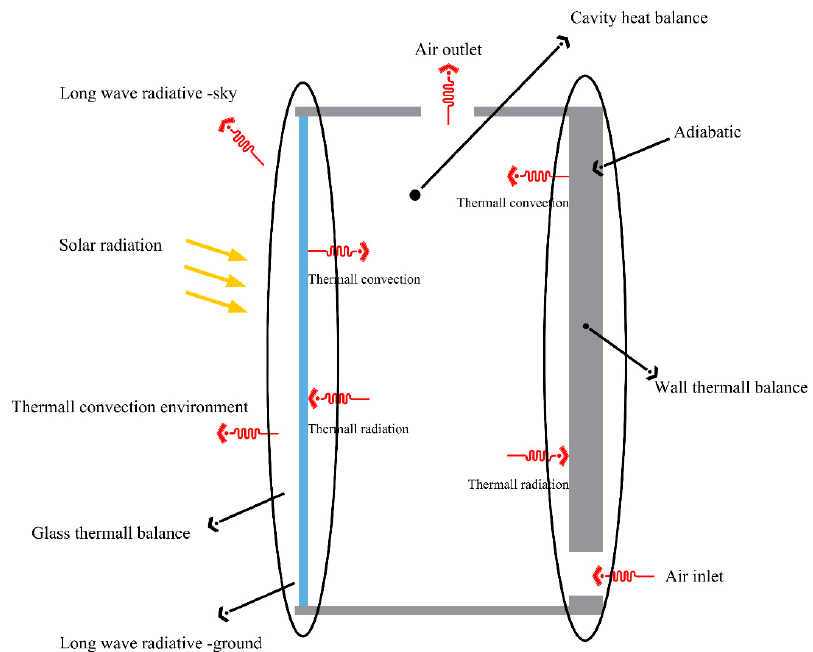
Figure 2. Wall-mounted solar chimney heat transfer analysis diagram.